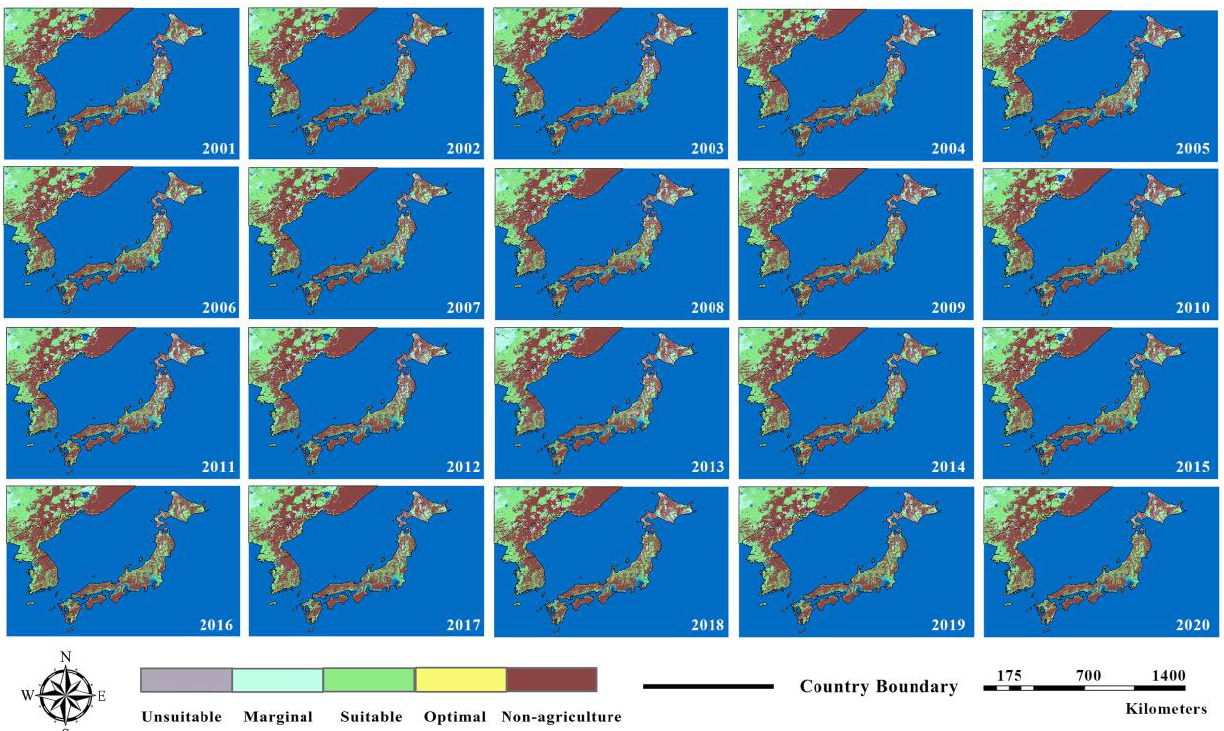
Figure 6. Bio-geophysical suitability maps of East Asia from 2001 to 2020 in winter. In Japan, the ranking of the seasons according to suitability level across two decades is summer > autumn > spring > winter. Since Japan has the largest latitude span, the north Hokkaido areas can be extremely cold in winter; despite this, Hokkaido has a large number of farmlands, therefore Japan had the most extensive rate of marginal and unsuitable levels in winter among the four countries. The northeast regions of China were found to be conducive for the growth of Chinese cabbage during the summer season. In spring and autumn seasons, there were sometimes huge differences in suitability from year to year since the climate of these seasons was unstable. In addition, China has undergone tremendous development changes in the past 20 years; the ratio between urban and rural areas is constantly changing, and some industrial pollution of the soil caused by urbanization may also make Chinese cabbage less likely to grow [67,68]. In South Korea, the best seasons are spring and autumn, but other two seasons were all good enough to grow Chinese cabbage; this could be one possible reason that Chinese cabbage has been one of the main ingredients of Korean dishes. In North Korea, according to the suitability analysis of 20 years, the ranking of the suitable seasons is summer > spring > autumn >